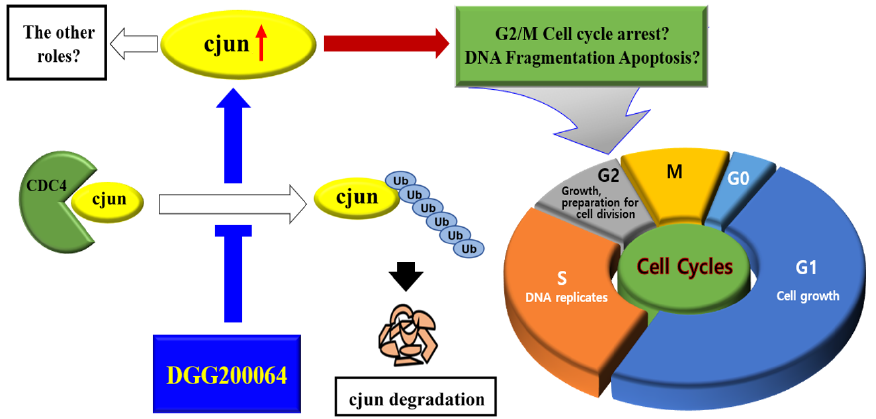
Figure 1. G2/M Cell cycle arrest research concept diagram.